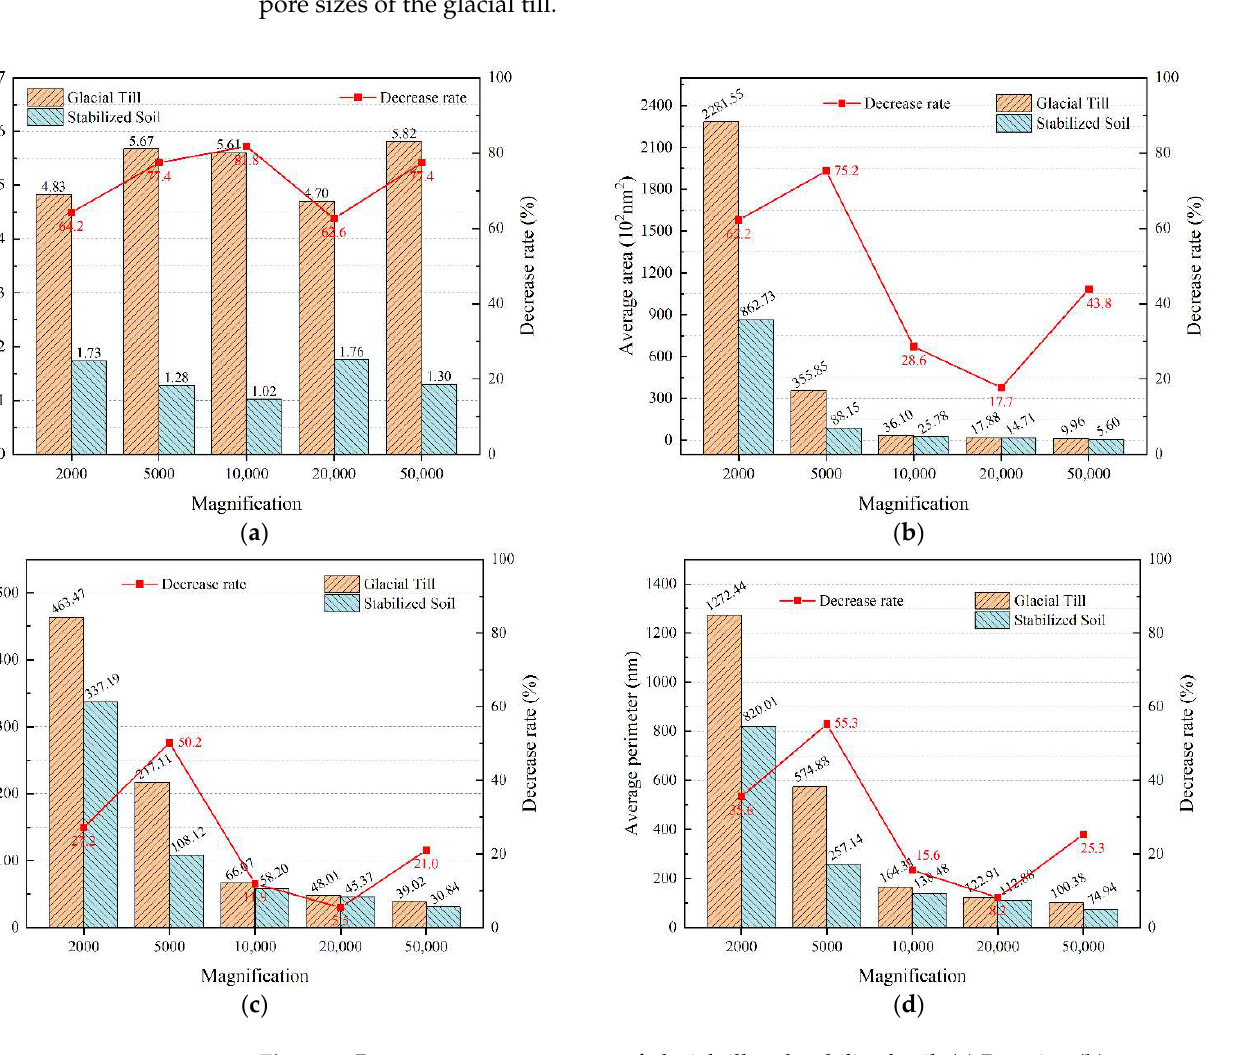
Figure 9. Pore structure parameters of glacial till and stabilized soil. ( a ) Porosity; ( b ) average pore area; ( c ) average pore caliper diameter; ( d ) average pore perimeter.